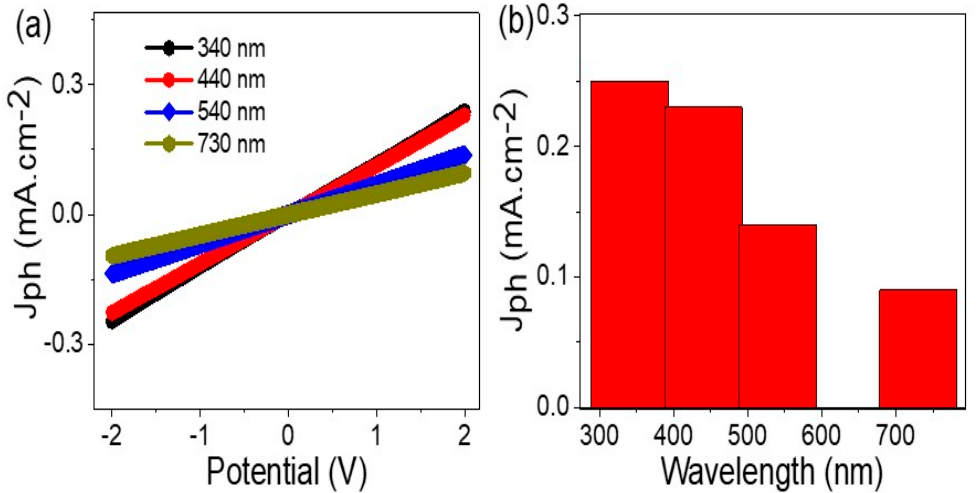
Figure 6. The electrical study of the roll-GO/PANI photodetector through the ( a ) current vs. voltage relation and ( b ) the produced J ph value at 2.0 V.